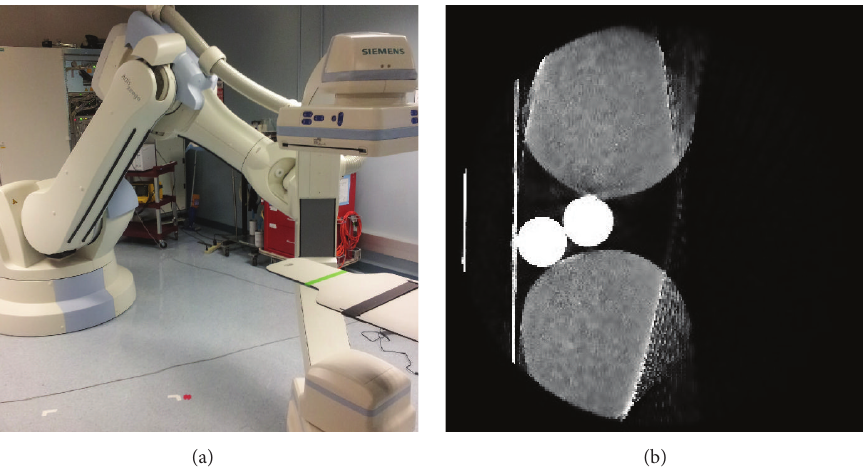
Figure 1: (a) The Siemens Zeego C-arm CT system. The robotic arm allows free movement of the C-arm for scanning patients in standing position. (b) Typical artifacts that arise when scanning knee-shaped objects with a C-arm CT. Due to saturation, the original cylindrical shape is lost, and the front is severely affected by artifacts (window level [ − 1000,